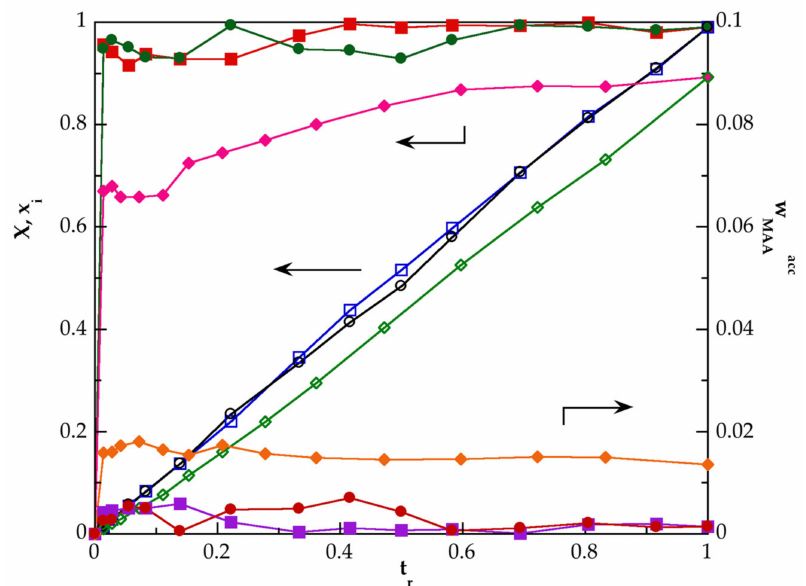
Figure 2. Advancement of instantaneous, x i (close symbols) and global X (open symbols) conver- sions and weight fraction of residual monomer, w acc polymerization of pure MAA to synthesize the PMAA 2 ( (cid:7) of MAA and G 3.0 -CNTs-PAMAM-NH 2 to prepare the nanocomposites PMAA–CNTs 3 (